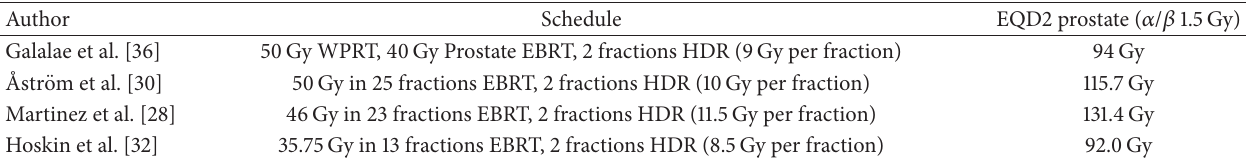
Table 2: Estimated equivalent doses (2Gy per fraction) for published HDR schedules using the EQD2 formula, assuming 𝛼/𝛽 for prostate cancer of 1.5Gy